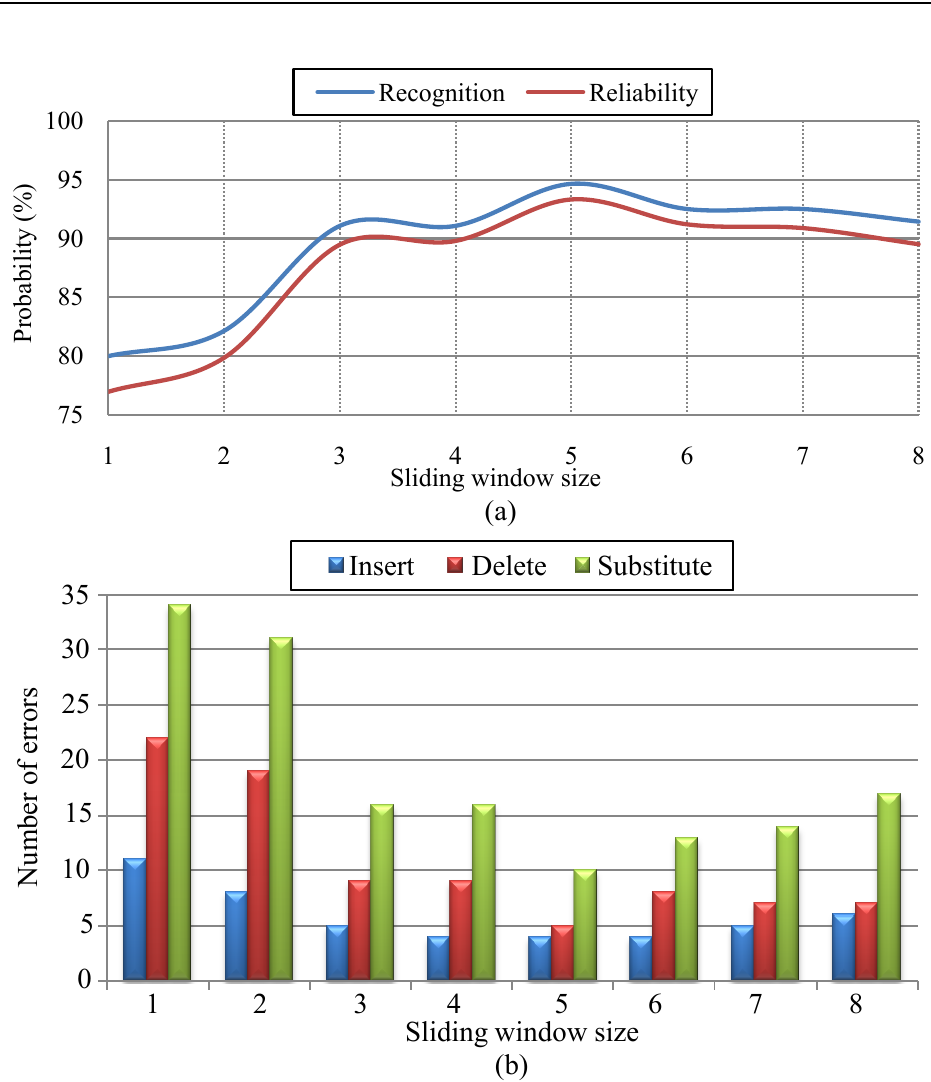
Figure 12. ( a ) Gesture spotting accuracy for various sizes of Sw from 1 to 8; ( b ) comparison of three types of errors (insertion, deletion, and substitution) according to various sizes of Sw